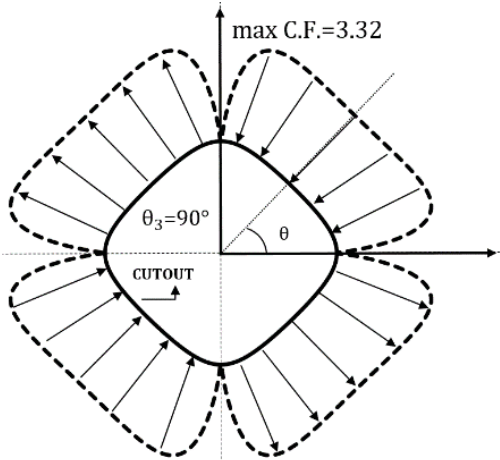
Figure 9. Optimal stress distribution around quasi-square cutout computed by MATLAB.